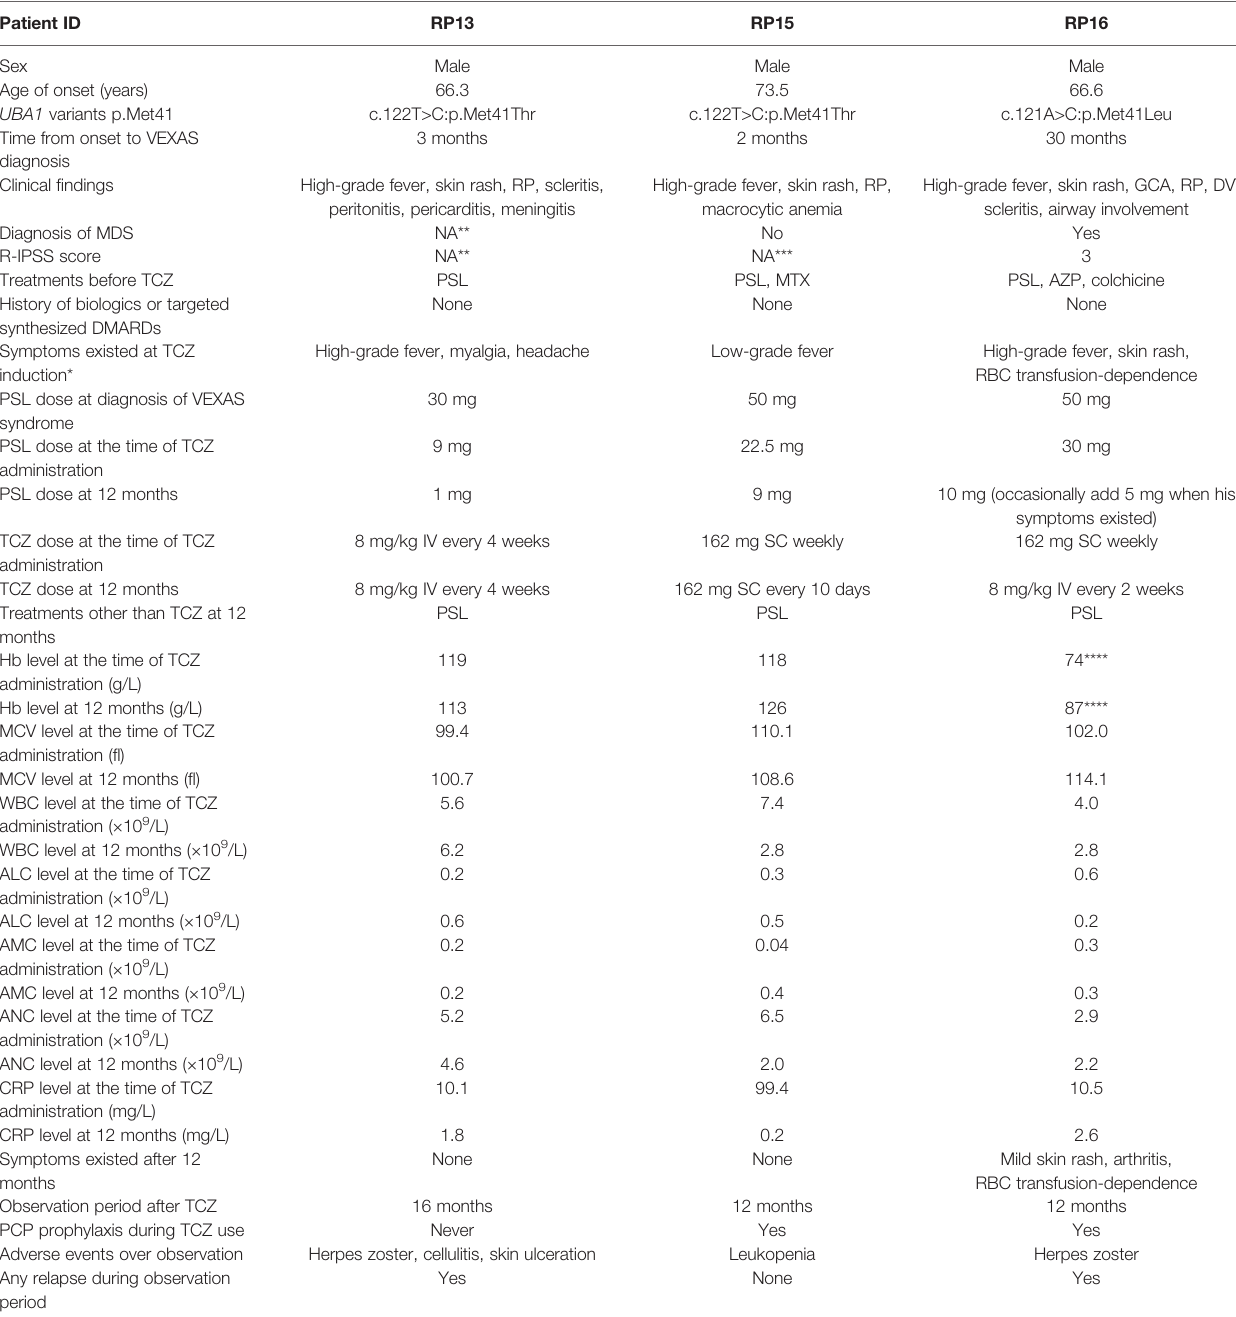
TABLE 1 | Clinical characteristics of the three VEXAS-RP patients treated with